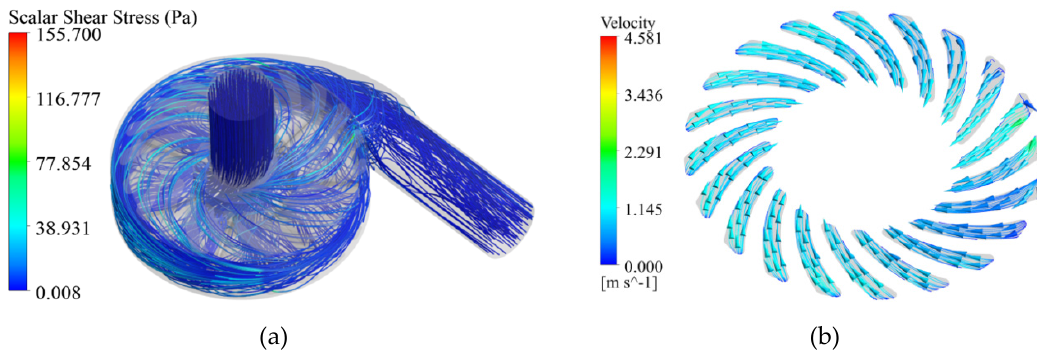
Figure 14. ( a ) Flow trace of blood under shear stress in the whole flow field of the blood pump. ( b ) Track of blood flow in the spiral groove.